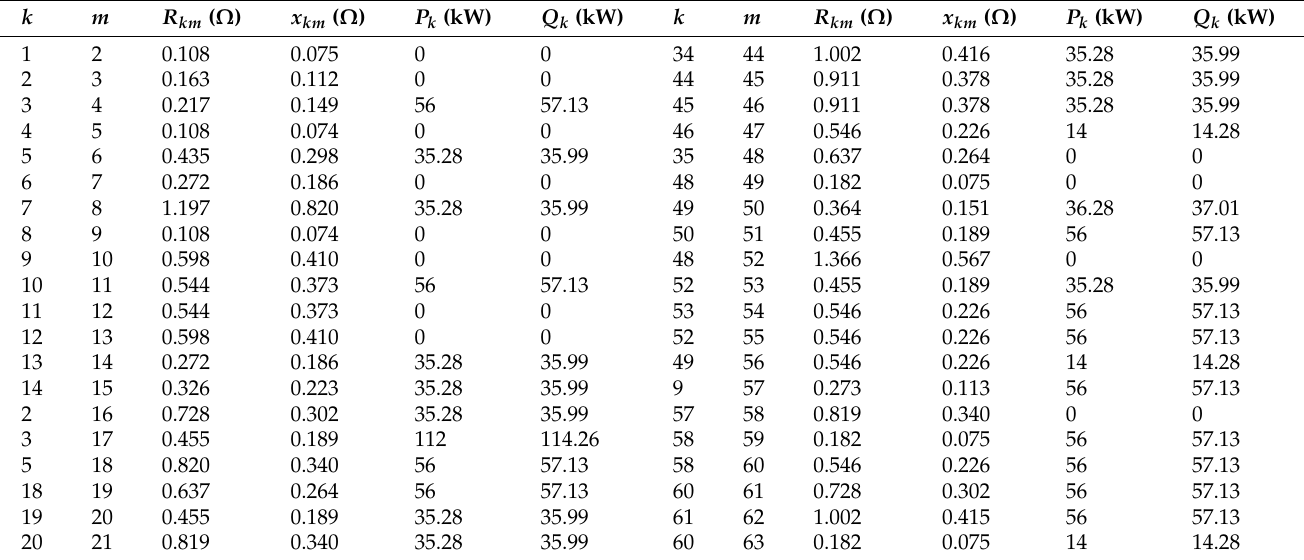
Figure 10 Bus voltages at each bus after compensation by different techniques for 85-bus test system.